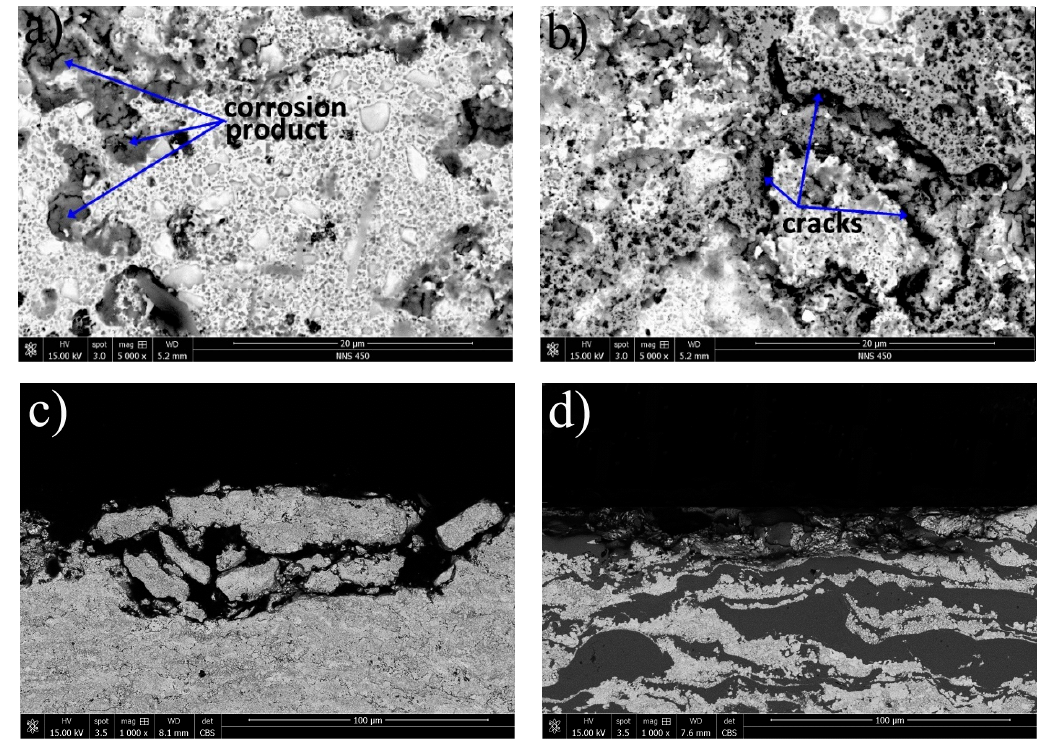
Figure 13. Surface and cross-section morphologies of ( a , c ) WC–CoCr coating and ( b , d ) composite coating after the potentiodynamic polarization test in 1 M HCl solution.